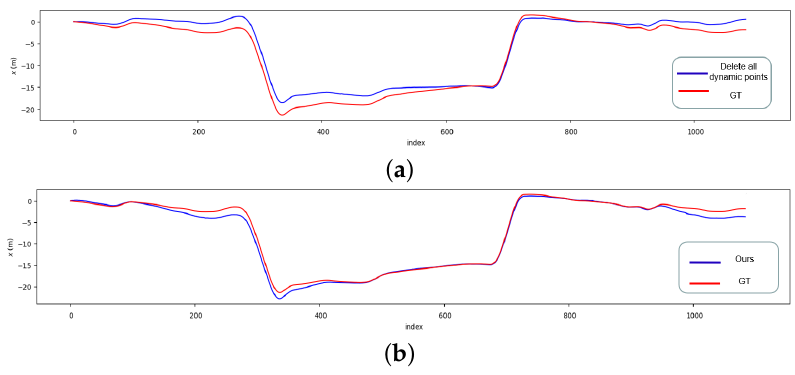
Figure 4. KITTI 06 dataset X-axis trajectory error, ( a ) Delete all dynamic points, ( b ) Ours.